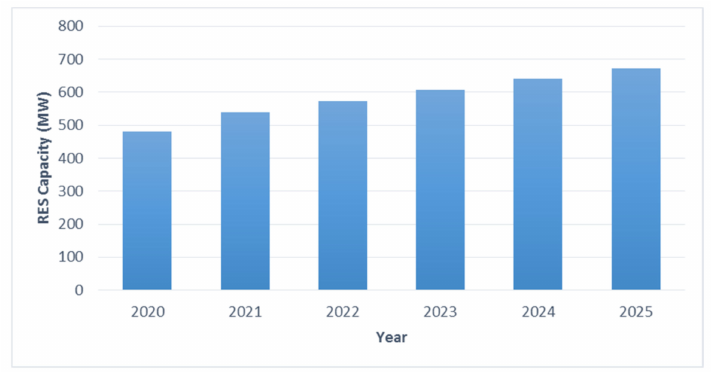
Figure 5. Estimated RES capacity for the years